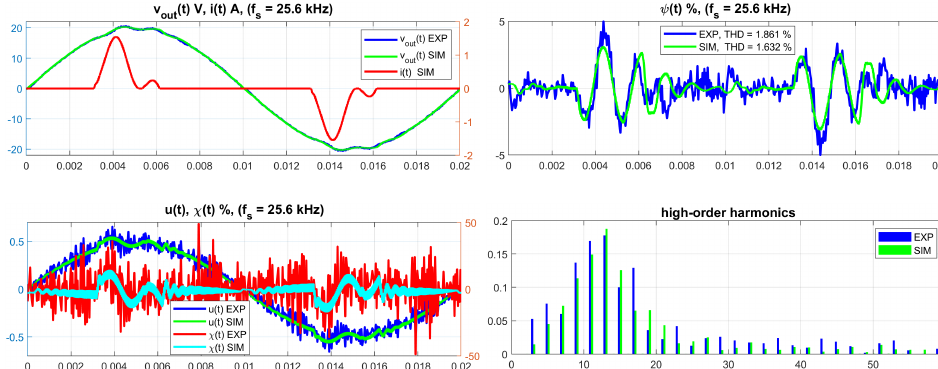
Figure 25. Experiment (EXP) vs simulation (SIM). Notice residual ripple in χ ( t ) and ψ ( t ) . The experiment was carried out before installing the output filter to the separation amplifier. Despite of these imperfections, a close proximity of theoretical and experimental results can be observed. This proves the validity of our models in predicting the behavior of a real